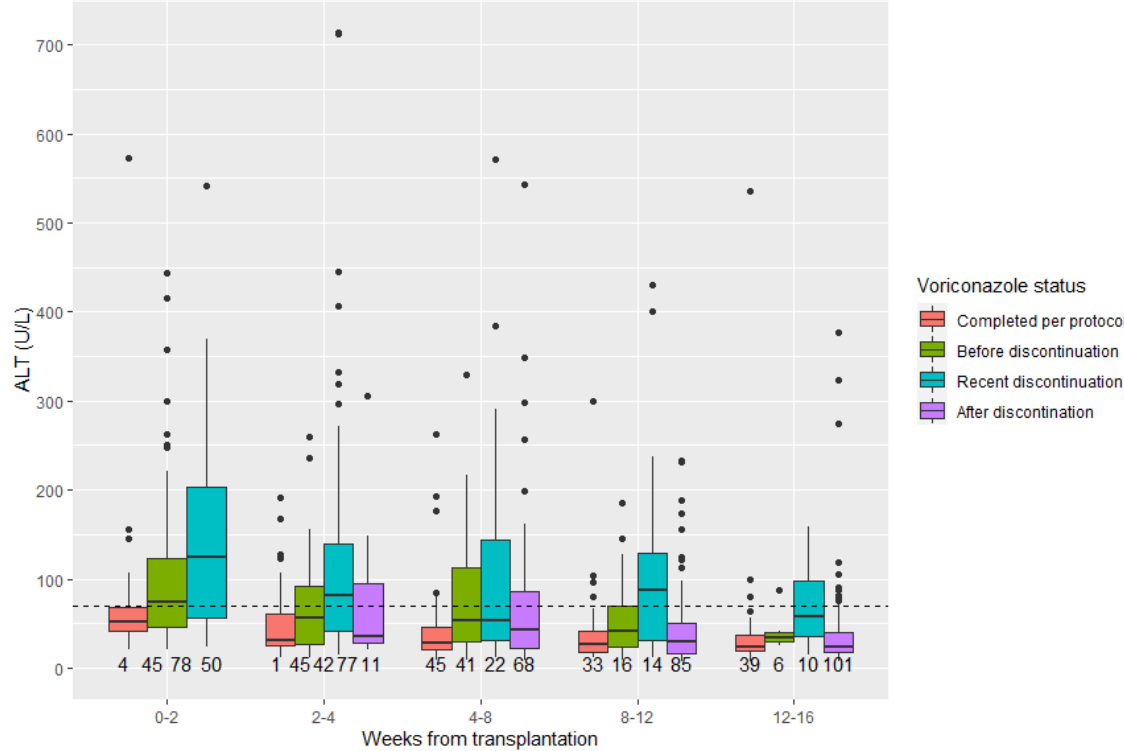
Figure 2. Alanine aminotransferase levels in lung transplant recipients initiating universal voricon- azole prophylaxis. Box plots with peak values of alanine aminotransferase (ALT) per patient in each time period are grouped according to voriconazole status. Peak ALT values for each patient were recorded in time intervals after transplantation and were categorized according to the status of voriconazole prophylaxis. Values in patients who had started voriconazole and completed it per protocol were grouped as “Completed per protocol”. The values of patients who, at some point, discontinued prophylaxis prematurely, but were still on voriconazole in the current time period, were categorized as “Before discontinuation”. Those who had discontinued voriconazole within a 14-day period were categorized as “Recent discontinuation”, and those who had discontinued voriconazole more than 14 days earlier as “After discontinuation”. The number of observations per group is shown below each box plot. Dashed line indicates male upper limit of normal (70 U/L). 3.3.2. High CNI Plasma Levels During the first 120 days after transplantation, the total number of CNI measure- ments taken per patient was similar in the two prophylaxis periods, with a median of 38 samples per patients in both periods (number of measurements per patient displayed in Appendix D). The proportions of LTXr with ≥ 1 episode of elevated CNI plasma level were comparable in the universal and the targeted prophylaxis periods (22% vs. 28%, p = 0.26). The proportions of LTXr with creatinine elevation were also comparable in the two peri- ods (Table 2). No significant difference was found in the proportion of LTXrs with ele- vated creatinine associated in time with a high CNI episode (4% vs. 9%, p = 0.17) when comparing the universal vs. the targeted period, respectively. 3.3.3. Low CNI Plasma Levels More patients had ≥ 1 episode of low CNI plasma levels in the universal prophylaxis period vs. the targeted prophylaxis period (89% vs. 72%, p < 0.001). The median number of low CNI episodes per patient was two (IQR 1–3, range 0–12) and one (IQR 0–2, range